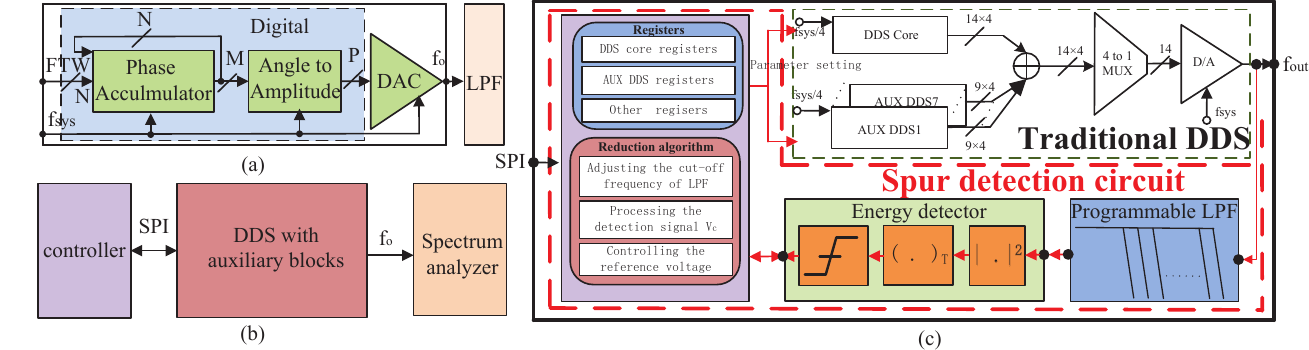
Figure 1. ( a ) The traditional architecture, ( b ) the traditional output spectrum reduction system, and ( c ) the spurs detection system of traditional